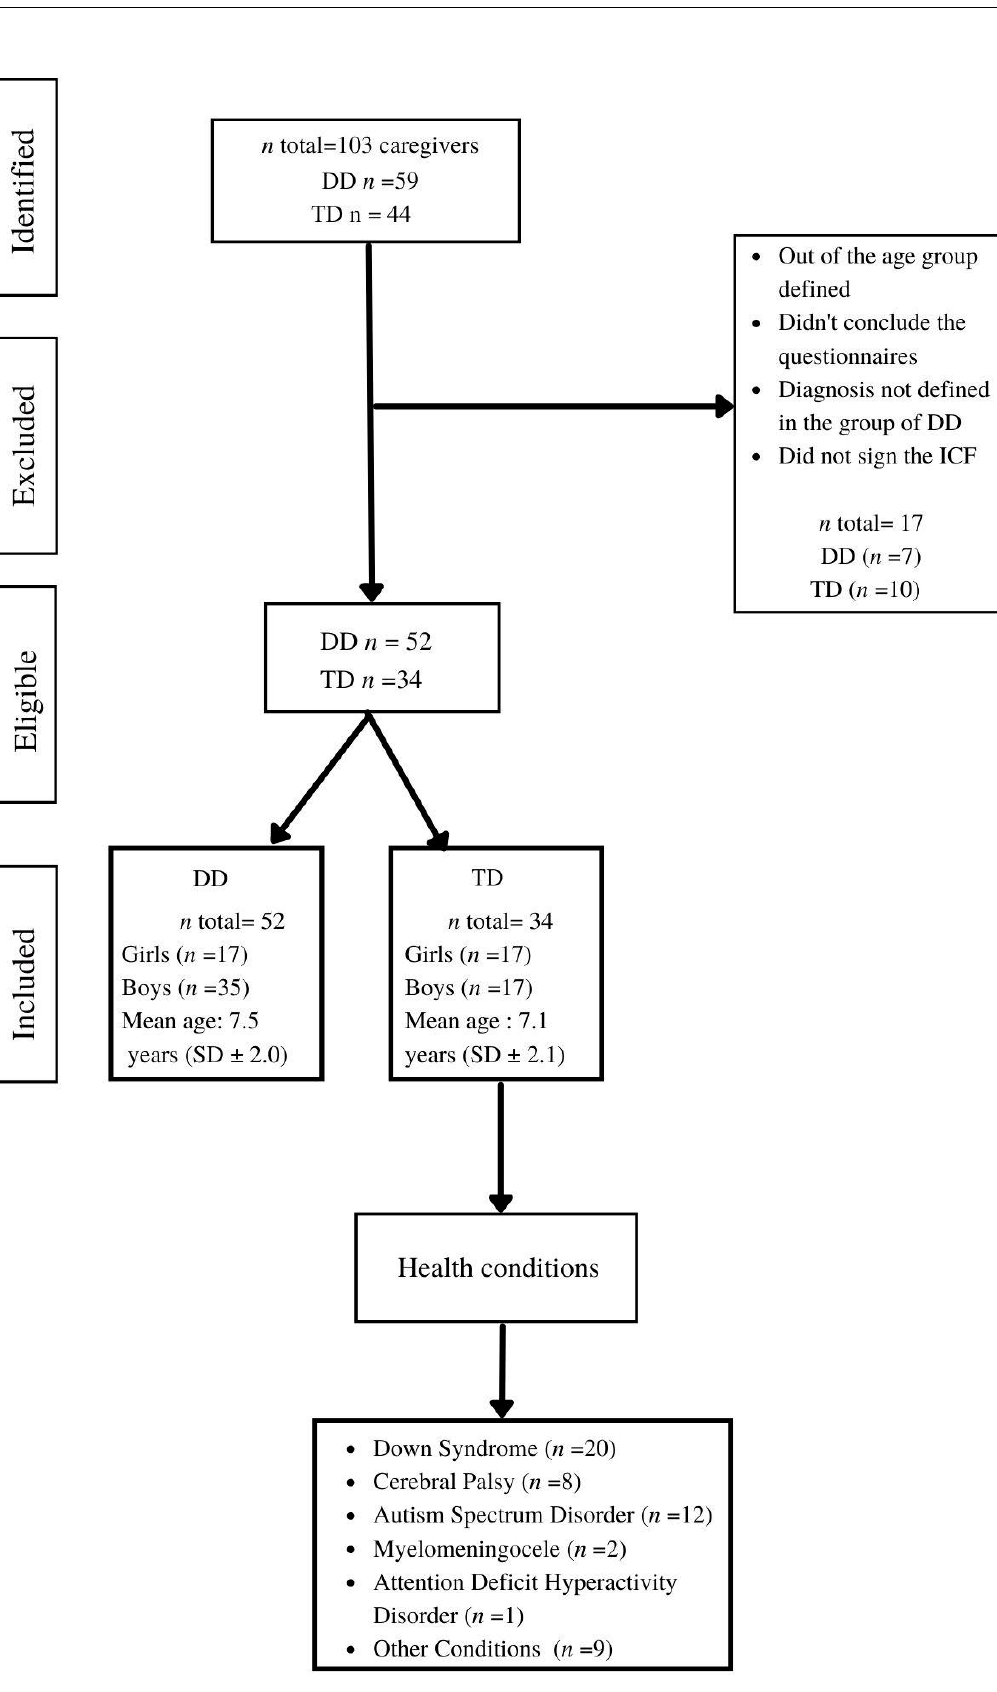
Figure 1. Flowchart of the participants. Legend: n = number of participants; DD = developmental disabilities; TD = typical development; SD = standard deviation; ICF = Informed Consent